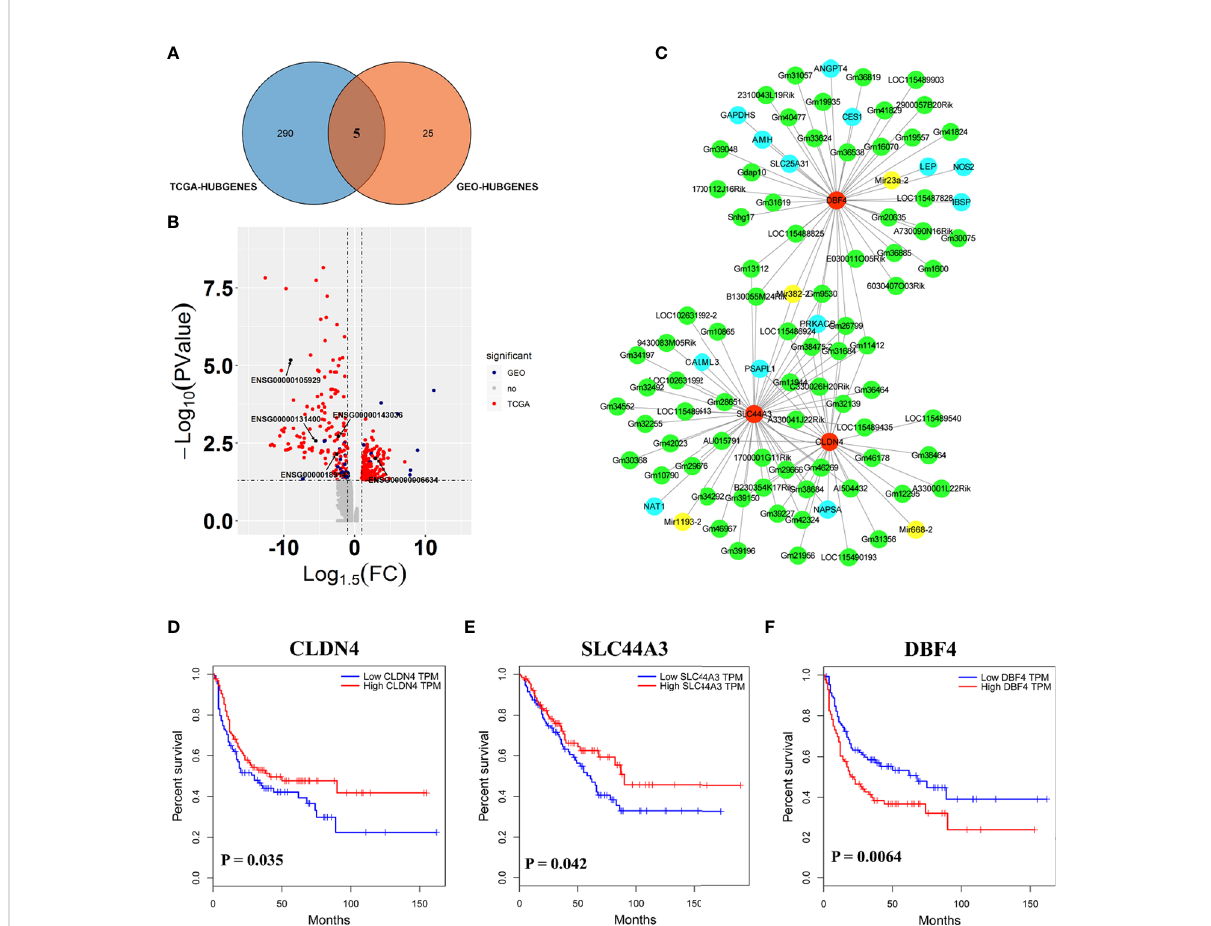
FIGURE 4 Three genes played important roles in the potential mechanism of harmine-treated cancer. (A) The Venn diagram demonstrates the intersections of genes between GEO data and TCGA data. (B) Volcano plot of genes functioned in key pathways identi fi ed in TCGA and GEO datasets. (C) The co-expression network of ceRNAs. Nodes and edges represent the proteins and interaction relationships between DEGs, respectively. Red nodes indicate the key genes discussed in the present manuscript, green nodes indicate lncRNAs, blue nodes indicate hub genes, and yellow nodes indicate miRNAs. (D – F) Disease-free survival (RFS) analysis for GEO and TCGA consensus genes, P <0.05 ( SLC44A3 , DBF4 , and CLDN4) . The blue line represents SARC patients with relatively low SLC44A3 , DBF4 , and CLDN4 mRNA expression, and the red line represents SARC patients with high expression of the aforementioned